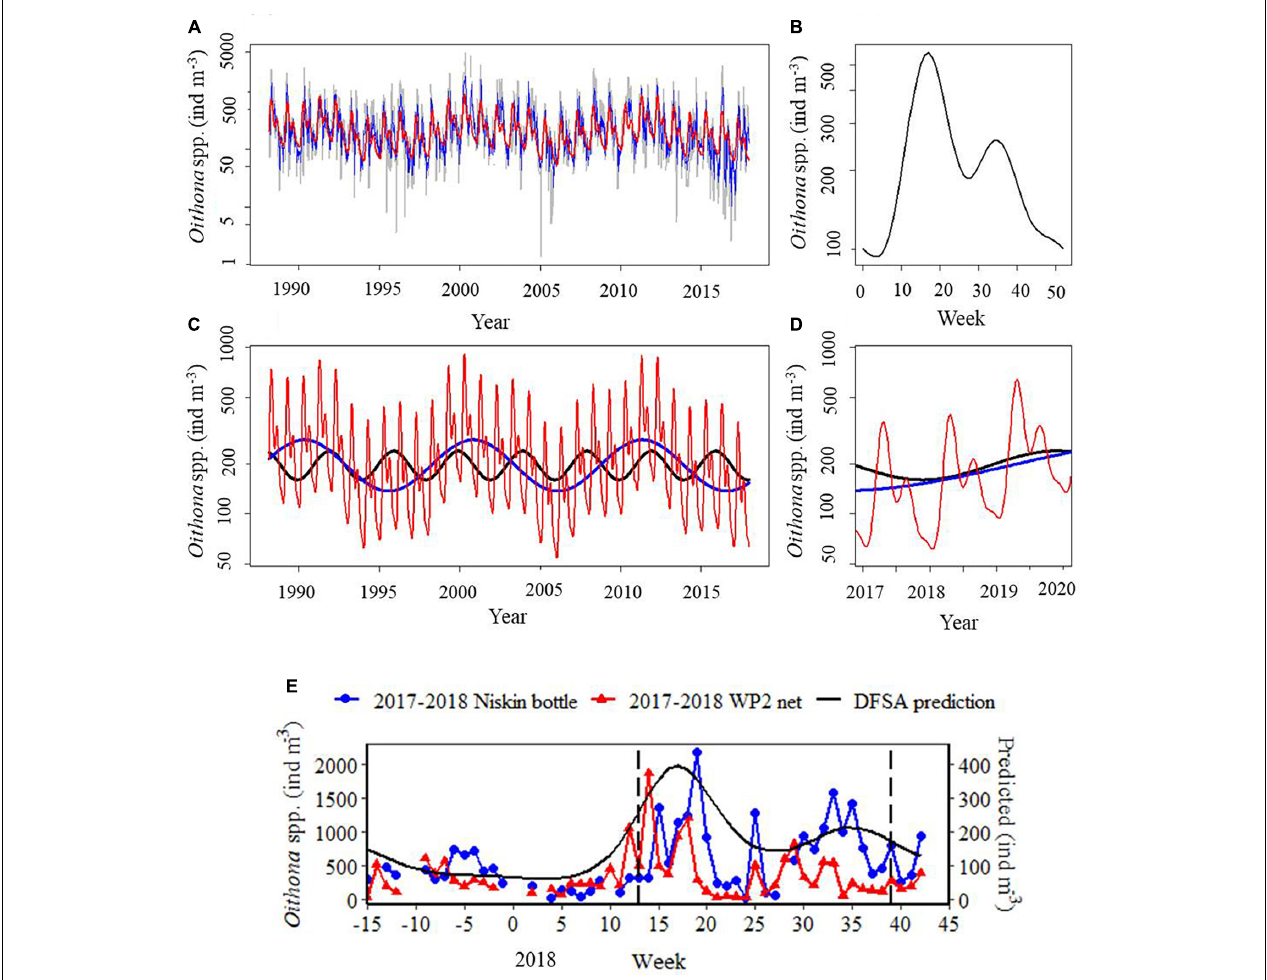
FIGURE 3 | Dominant frequency state analysis (DFSA) of the Oithona spp. dynamic for (A) the time series (1988–2017) (grey), dominant frequency components (red), autoregressive noise components (blue); (B) the baseline Oithona spp. seasonal dynamic (1, 1/2 and 1/3 year cyclic terms) for the time series (1988–2017); (C) the dominant cyclic terms (blue: 10.5 years, black: 4 years) and baseline Oithona spp. seasonal dynamic (red) for the time series (1988–2017); (D) the DFSA-derived prediction of the Oithona spp. seasonal dynamic, lines as for (C) ; (E) depth-integrated density of Oithona similis adults from Niskin bottle sampling in the 2017–2018 study, Oithona spp. density from the WP2 net over the 2017–2018 study, and the DFSA-derived 2018 prediction of the Oithona spp. seasonal dynamic. Sub-figures (A – D) are on a logarithmic scale, and (E) on an absolute scale. In sub-figure (E) , the DFSA 2018 prediction had reduced variability compared to the real observations, and was thus plotted on the secondary axis to aid comparison. Vertical dashed lines mark the onset and breakdown of stratification, indicated by the switch in surface NHF from negative to positive (week 13), and positive to negative (week 39) during the 2017–2018